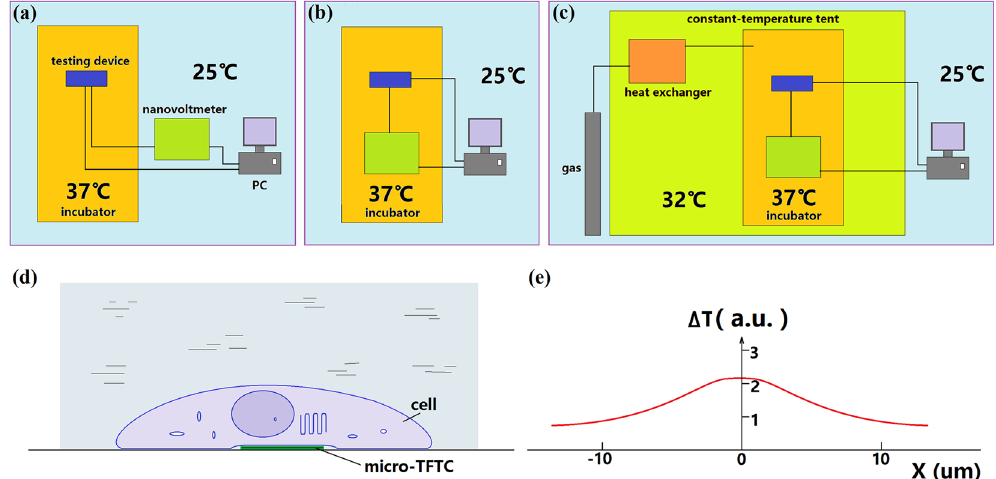
Figure 4. S chematic of the structures of measurement system and the measurement of local cellular temperature. ( a ) In normal practice, the testing device is put into the incubator at 37 °C and the other measurement instruments are put on the outside of the incubator at 25 °C. ( b ) The testing device and the other measurement instruments are put into the incubator at 37 °C, leaving the computer and monitor outside of the incubator at 25 °C. ( c ) A big constant-temperature tent kept at 32 °C is put on the outside of the incubator. Testing device and measurement instruments are put inside the incubator. The CO 2 gas tank, computer and monitor are put on the outside of the tent. ( d ) A live cell firmly sticks to the micro-TFTC sensor. ( e ) A non- uniform temperature distribution in the cell (15–25 μ m in diameter).